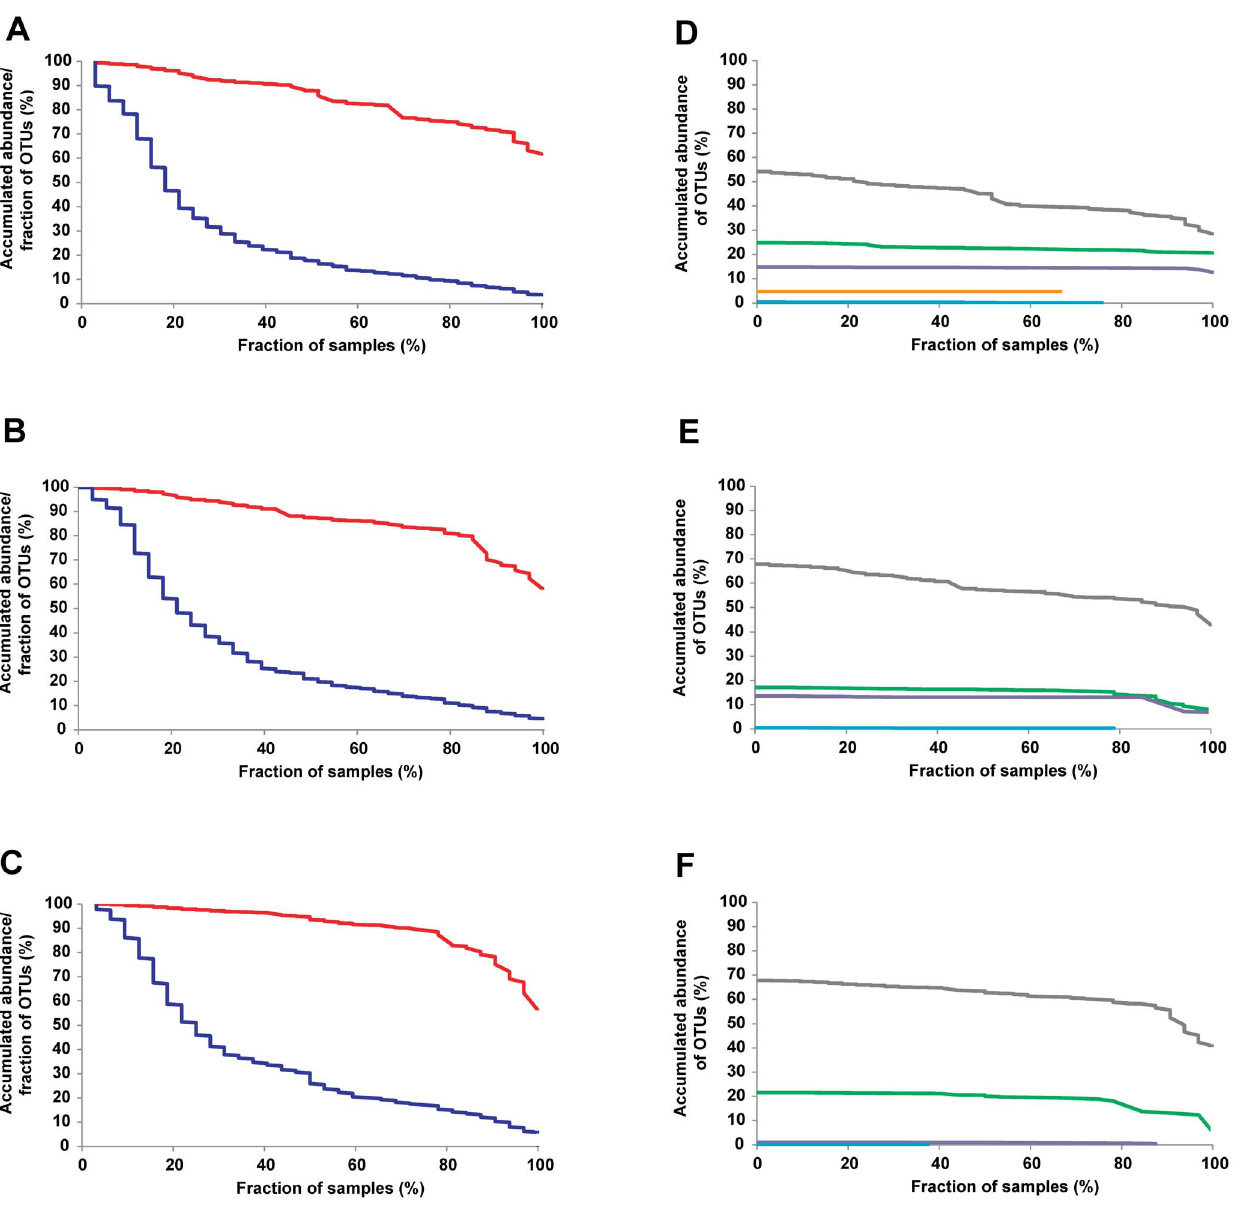
Figure 2. Individual fecal temporal core. Fraction of species-level OTUs shared across samples of the total OTUs within these samples (blue line) and the proportion that these OTUs represent of the total sequences obtained (red line) for subjects 1, 2, and 3 (A,B,C). Proportion of total sequence reads obtained of OTUs shared across sampled within the different phyla (Firmicutes: grey, Bacteroidetes: green, Actinobacteria: purple, Verrucomicrobia: orange, Proteobacteria: light blue) (D,E,F).